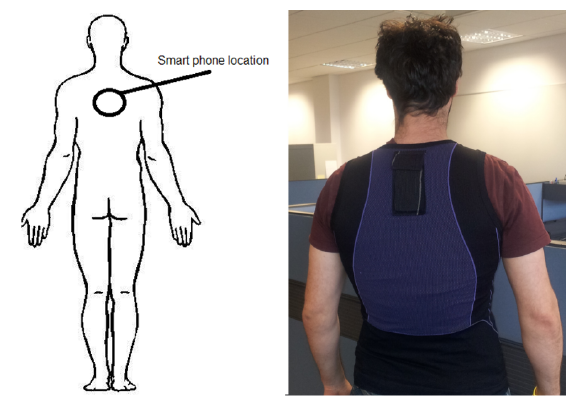
Figure 1. Location of